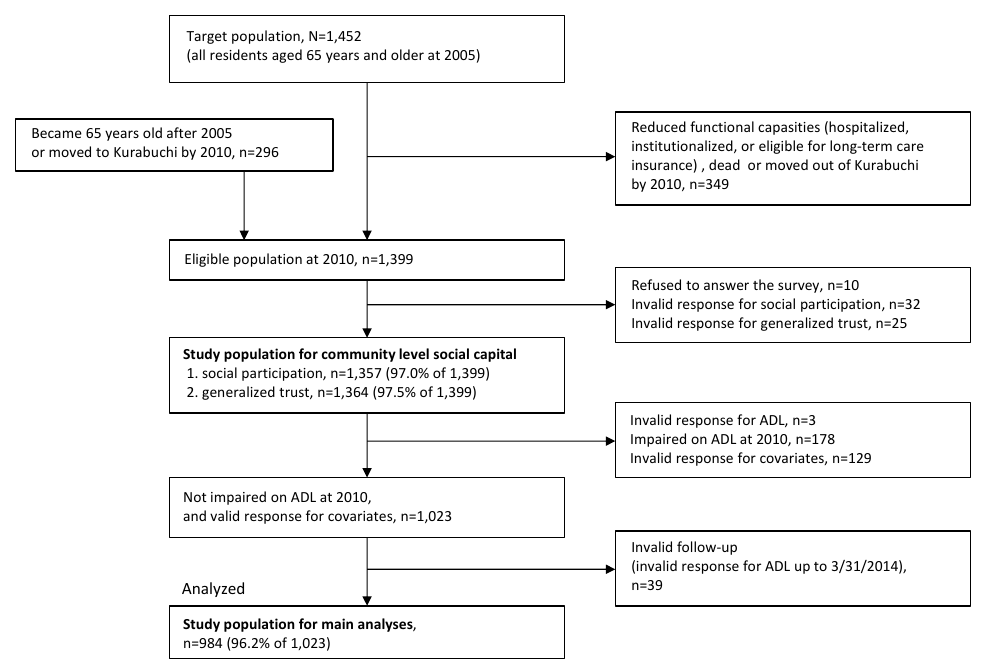
Figure 1. Study Figure 1. Study population.